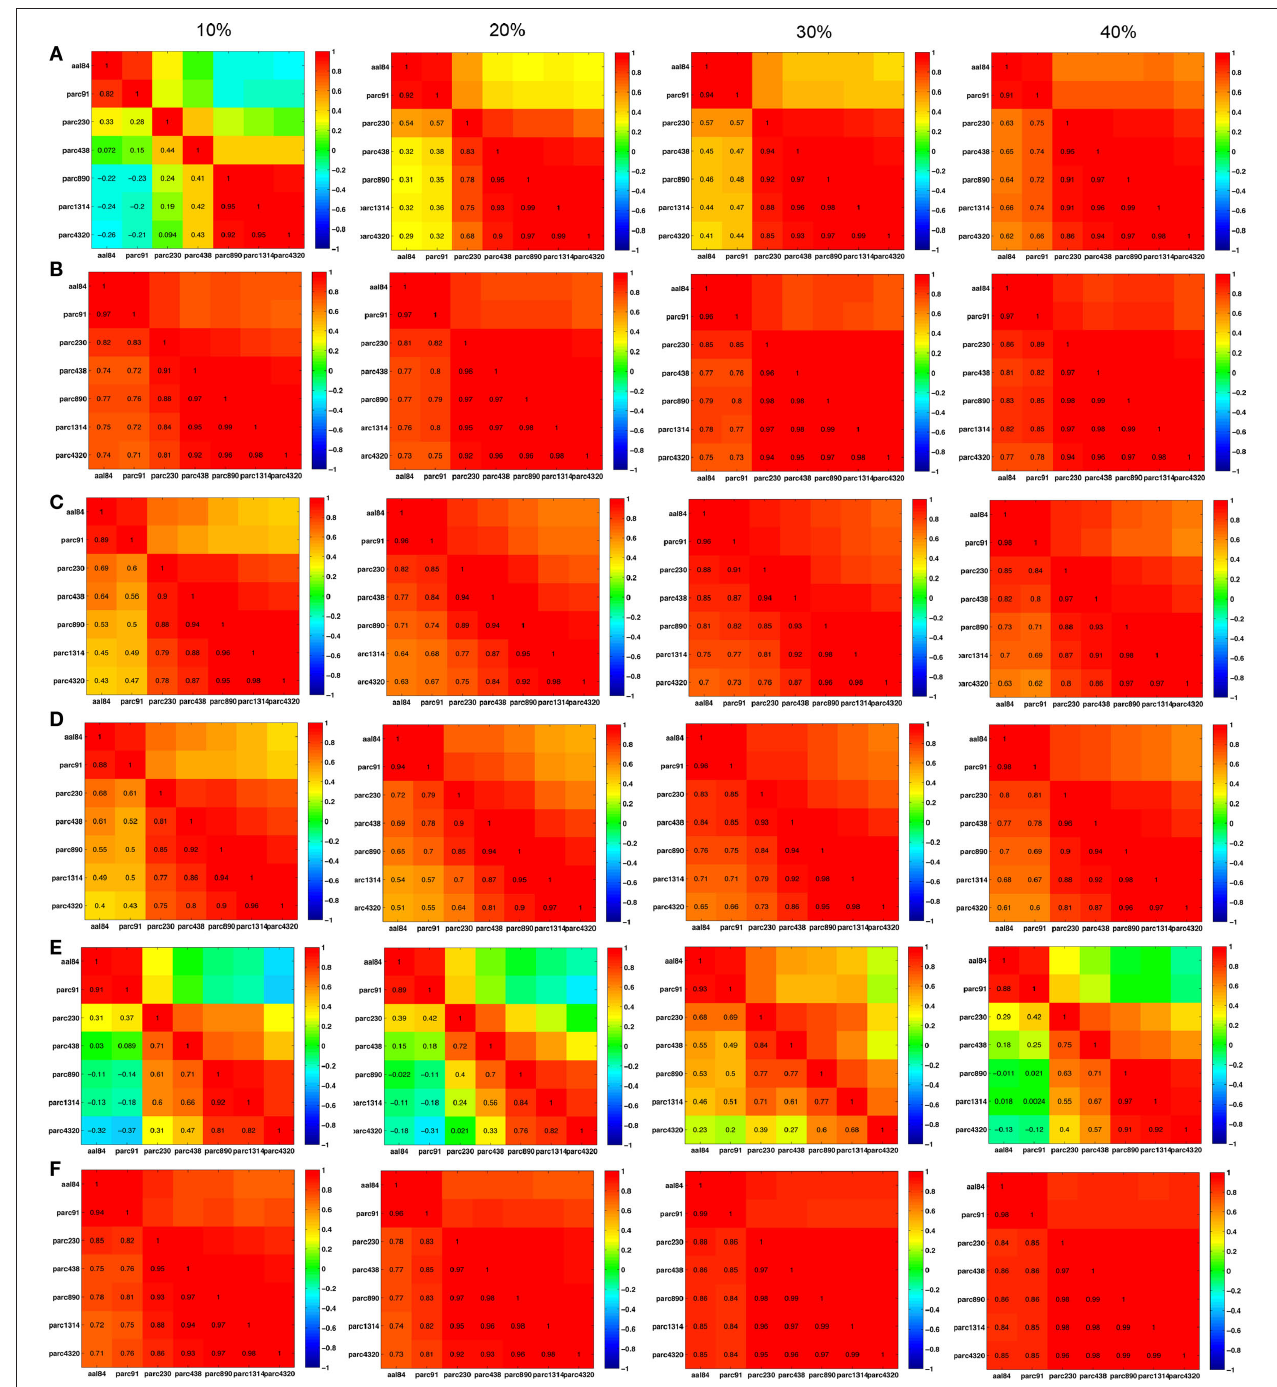
FIguRe 8 | Inter-scale correlations in global network properties at costs of 10, 20, 30, and 40%. (A) Clustering; (B) γ